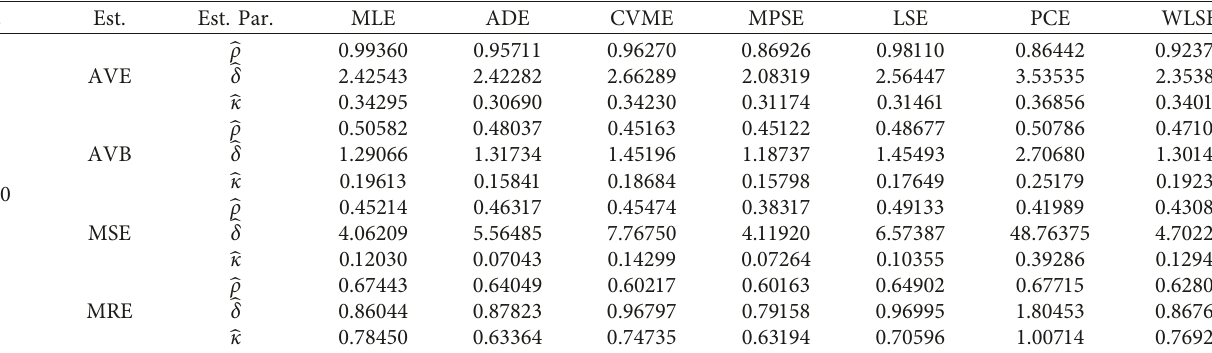
Table 3: Simulation results of the AVE, AVB, MSE, and MRE of BXLE distribution for ( ρ � 0 . 75 , δ � 1 . 50 , κ � 0 . 25 ) . n